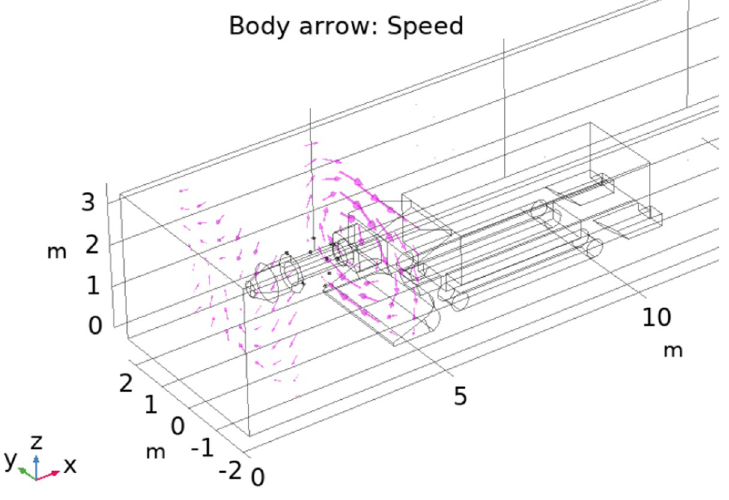
Fig 9. Airflow trend chart.